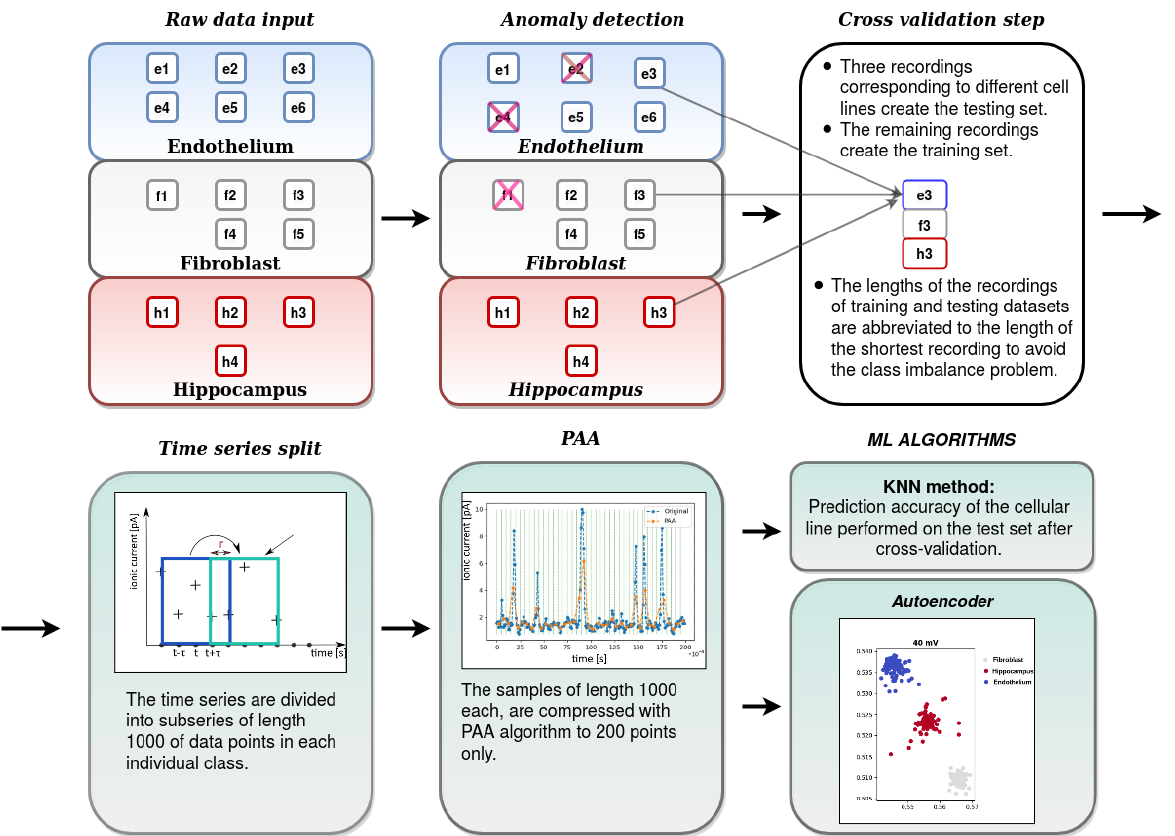
Figure 4. The scheme presenting the subsequent stages of the patch-clamp data